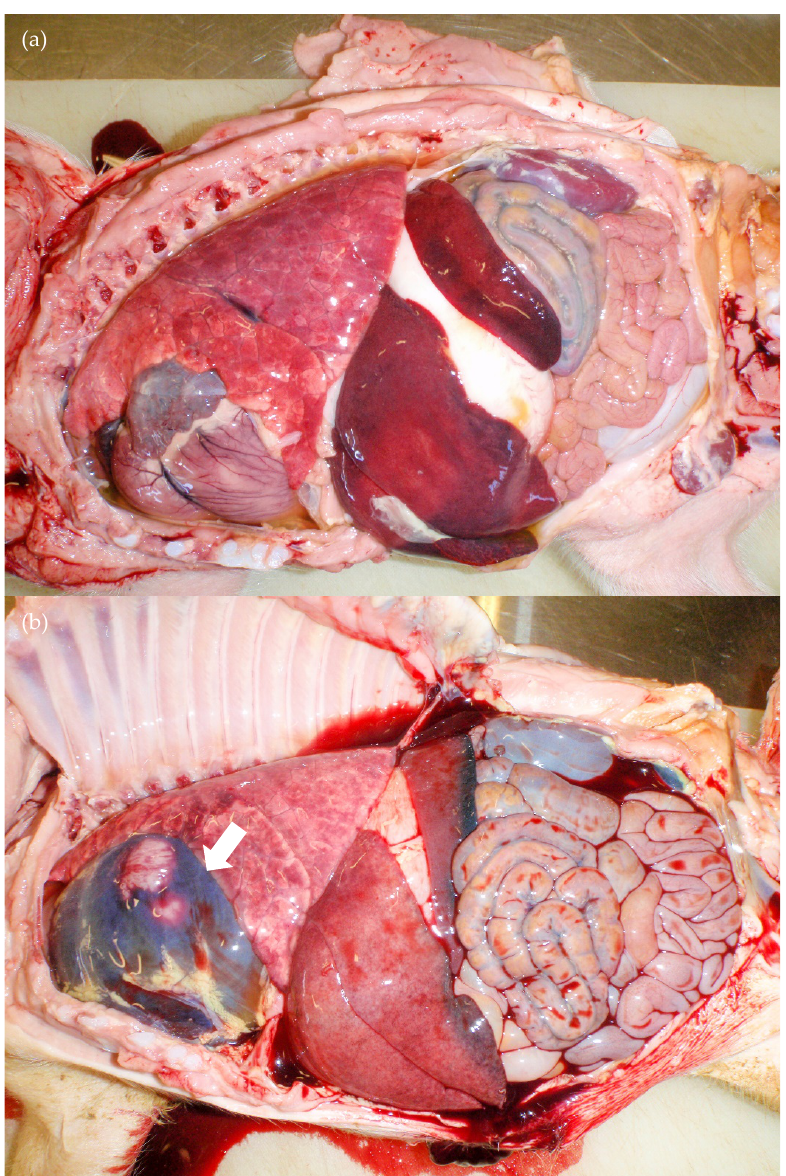
Figure 4. Necropsy findings from D90: ( a ) cardiac and hepatic enlargement (20-06; 7 days old) and ( b ) free blood in the unopened pericardial sac (arrow) and abdomen (19-02; 12 days old). From weaning to termination of the monitoring at 5 weeks of age, few gross lesions were observed. Bungowannah virus was cleared most rapidly from this group with virus shedding and the viral loads in tissues were only at low levels from 11 days of age or often not detected at all [22]. Interlobular pulmonary oedema was observed in two animals and fine fibrin tags were observed in the peritoneal cavity of five animals. The pig that exhibited an increased respiratory rate after exercise and survived to 5 weeks old (23-11) also showed mild interlobular pulmonary oedema and a smaller than expected thymus, but did not have definite cardiac enlargement. However, the ventricular walls appeared thinner than normal, suggesting possible cardiac dilation.